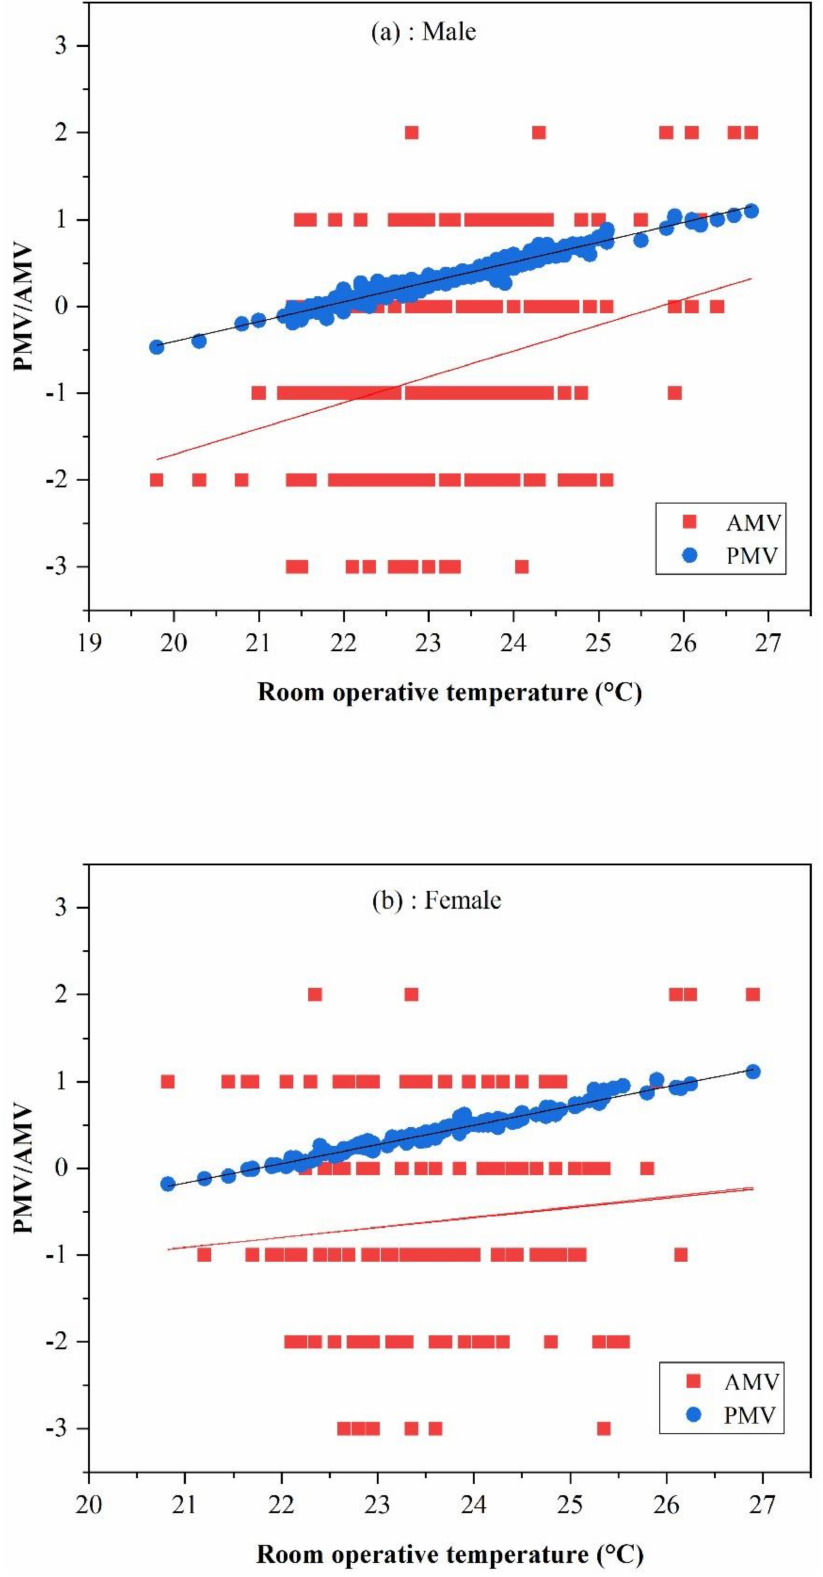
Figure 9. Comparison between actual mean vote (AMV) and predicted mean vote (PMV) versus operative temperature for ( a ) male and ( b ) female